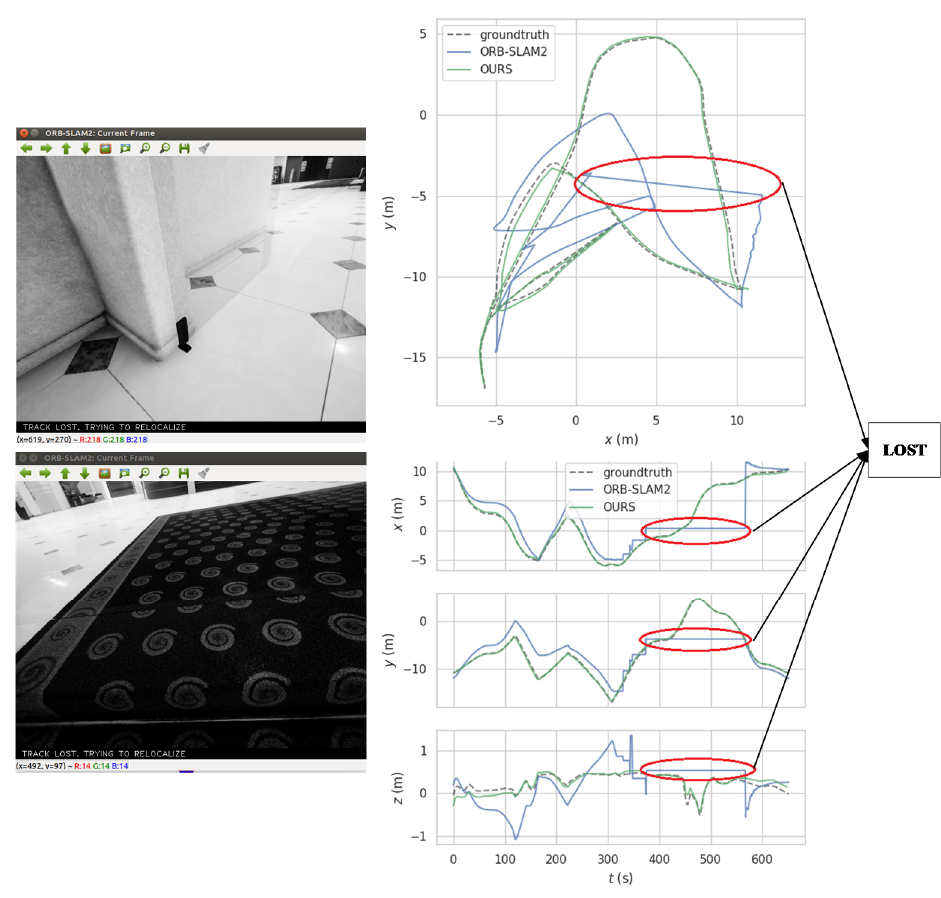
Figure 12. A motion trajectory of ORB-SLAM2 compared with our approach on the Hard-P001 sequence. The red circle in the figure shows that ORB-SLAM2 lost the tracking at runtime, and the left column shows the frames with the tracking lost.